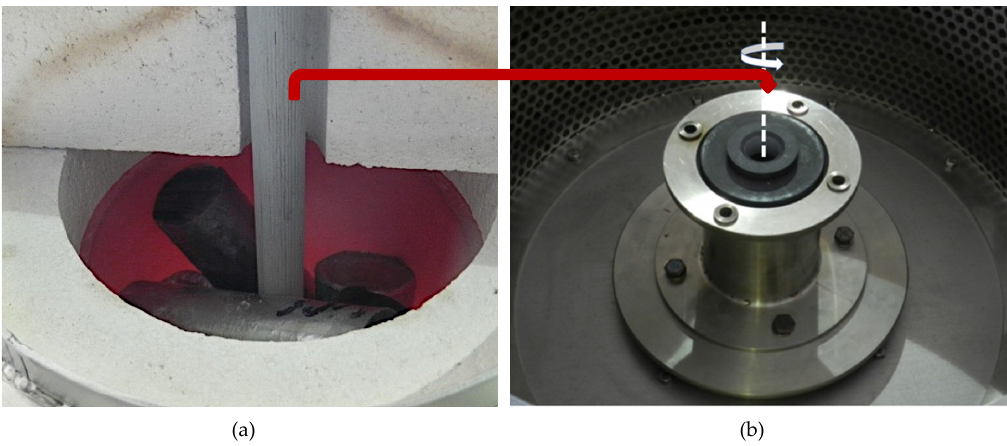
Figure 3. ( a ) A view of the melting chamber of a crucible furnace integrated with a technological process station MVO500; ( b ) a view of centrifugal mold rotating in the vertical axis system. The selection of proper material parameters such as the reinforcement particles size and type (Figure 2) and matrix alloy chemical composition (Table 1), as well as parameters of the centrifugal casting process in the vertical axis (i.e., the composite suspension pouring temperature as well as the temperature, diameter, and rotational speed of the centrifugal mold, cf. Table 2) enabled making castings in the form of sleeves with an outer composite layer with a thickness of about 6 mm distinctly visible on the cross-section of the casting (Figure 4). Selected model issues concerning the formation of a functional structure in metal–ceramic composites in the centrifugal casting process were already presented in [24]. Table 2. Technological parameters of the centrifugal casting process in the vertical axis.